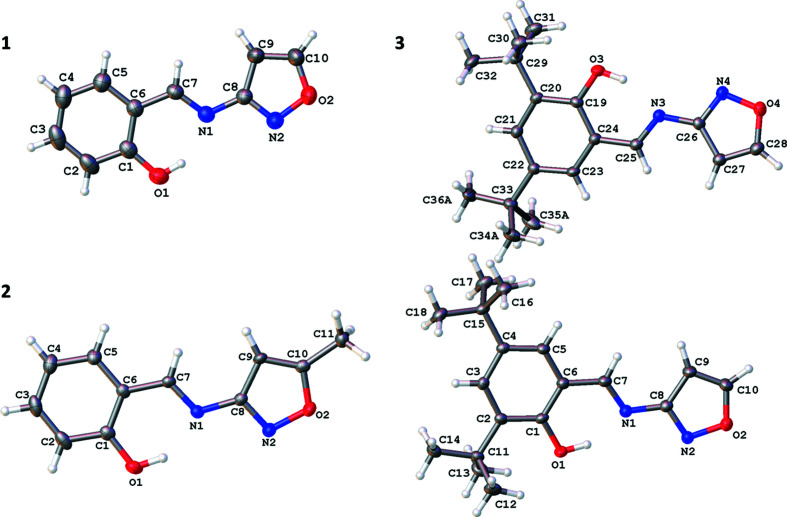
Illustration of the structures of 1 [at 210 (2) K], 2 [120 (2) K] and 3 [120 (2) K], with the atomic numbering schemes depicted. Anisotropic displacement parameters are drawn at the 50% probability level. In the case of 3, only one position of the disordered tert-butyl group is shown for clarity.